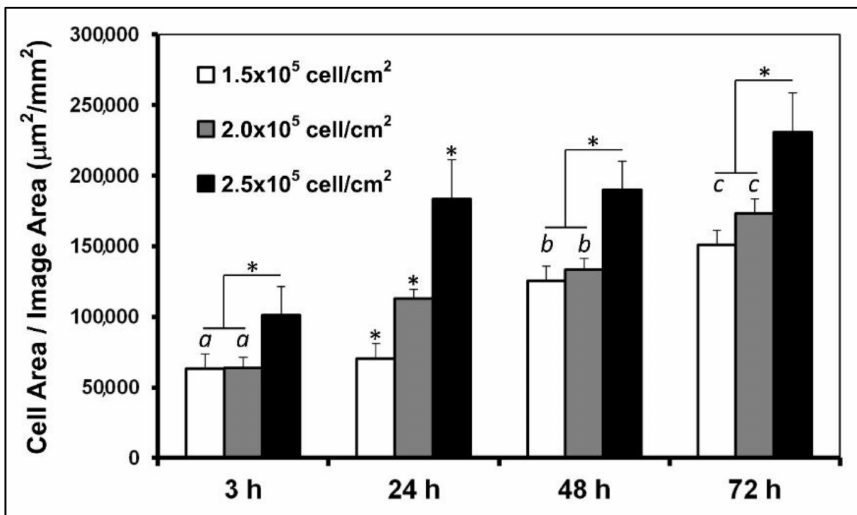
Figure 4. Spreading of muscle cells cultured on microstructured films. Asterisk (*) shows significant di ff erence ( p < 0.05; ANOVA; n = 10). Bars with same letter indicate no significant di ff erence between them ( p > 0.05; Tukey’s test; n =